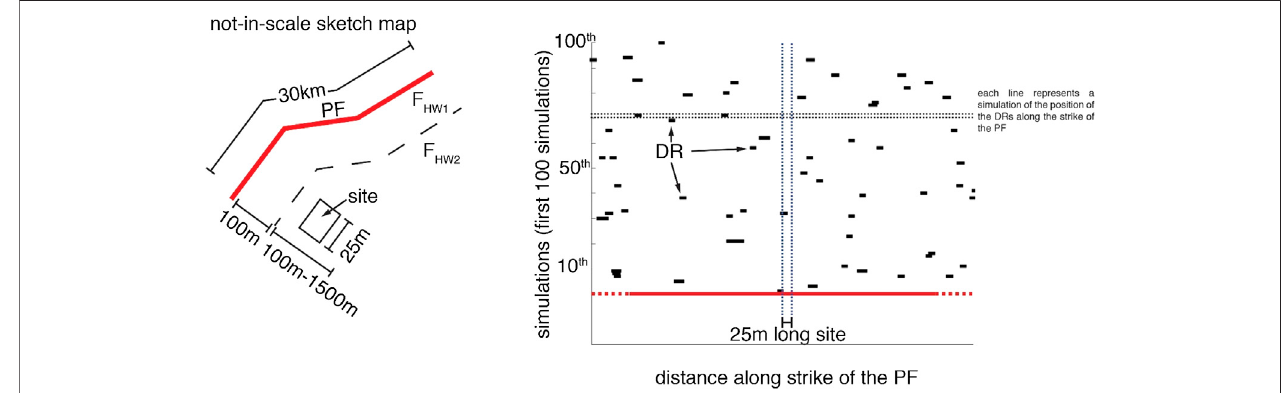
FIGURE 9 | A site of 25 m width situated on hanging wall in 100 – 1,500 m distance from a 30 km long principal fault (PF) and the fi rst 100 simulations of the existenceofdistributedsurfaceruptures(DR)atthesite.EachlineonsimulationplotrepresentsasimulationofpositioningDRsalongthePFstrike,andtheverticaldotted blue lines indicate the site of 25 m width in respect to the total length of the PF (red line).